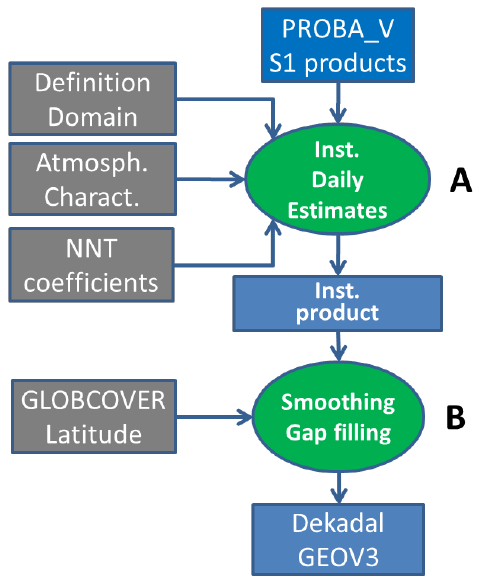
Figure 2: Flow chart of the LAI/FAPAR/FCover algorithm HYGEOS has translated this algorithm into a software